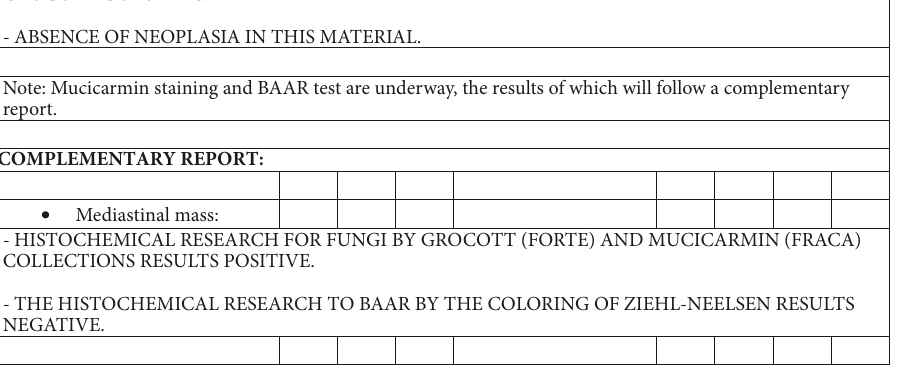
Figure 7: Histopathological